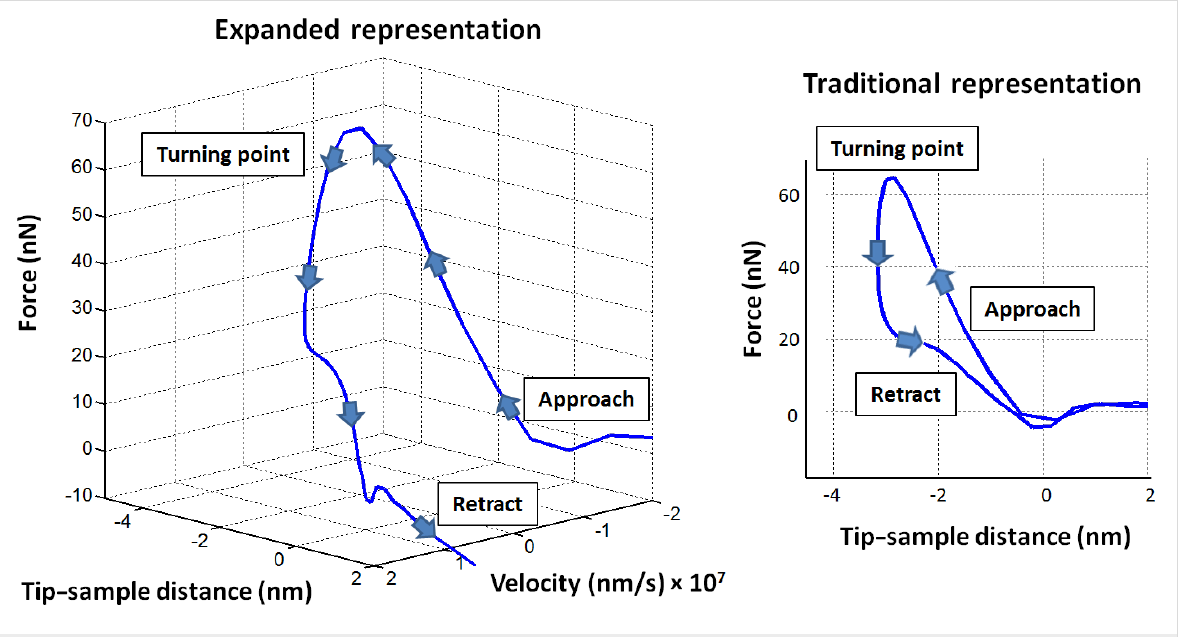
Figure 1: Simulated reconstructed tip–sample interaction force curve for a typical polymer, for a fixed ( x , y ) point on the surface for which the force is plotted as a function of the vertical tip–sample distance and the velocity of the cantilever tip (expanded representation, left), and only as a function of the vertical tip–sample distance (traditional representation, right). All force curves shown in this paper were constructed through simulation of the spectral inversion method [11]. In all cases the origin of the vertical position (tip–sample distance) axis is located at the relaxed position of the surface. The “turning point” is the lowest vertical position reached by the tip during tip–sample